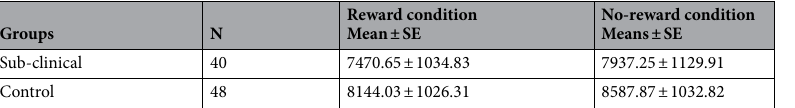
Table 3. Means and standard errors for reaction time (in ms) in the reward and no reward conditions. Participants reported faster reaction time to reward trials as compared to non-reward trials.